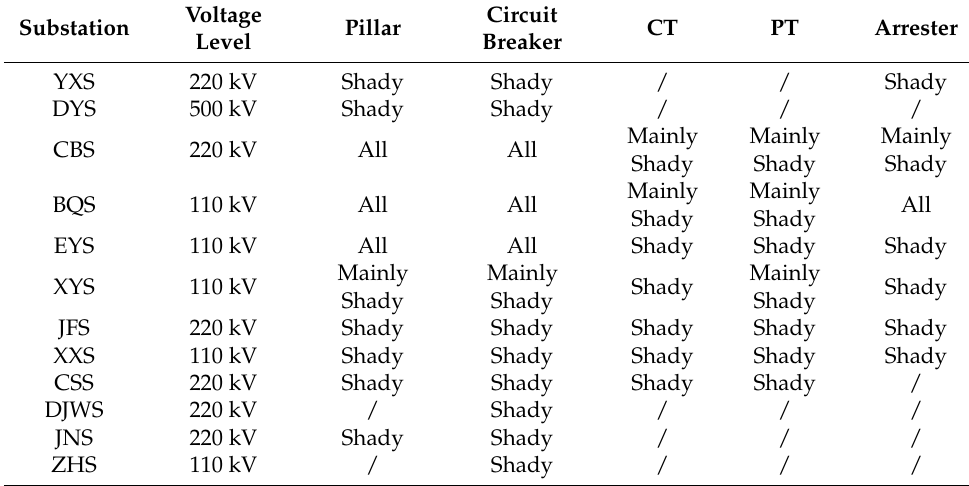
Table 2. The algae growth direction on the RTV coating for each substation.